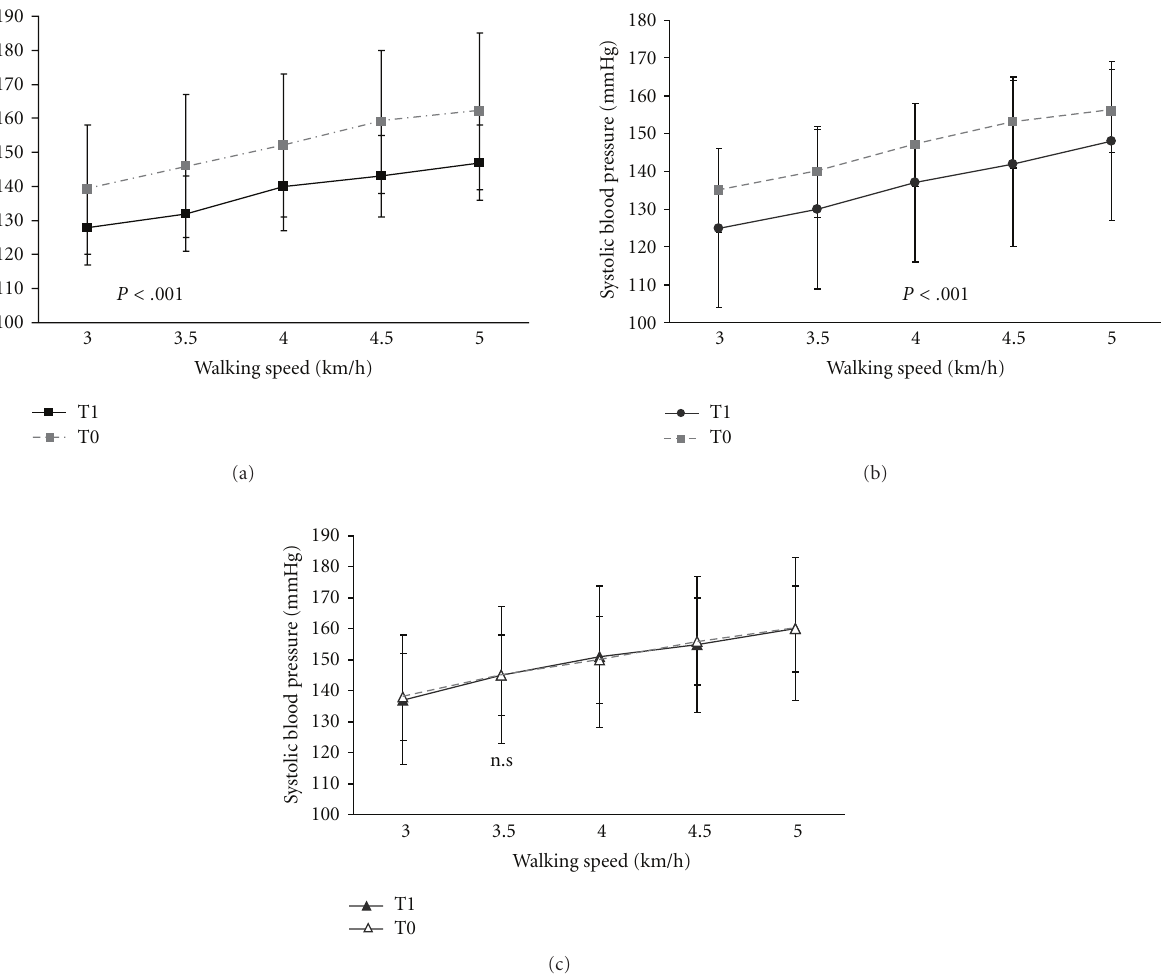
Figure 6: (a) The increase of the systolic blood pressure with increasing walking speed was significantly lower after completion of the training programme in the Nordic walking ((a)) and the walking group ((b)) but not in the flexibility and relaxation group; ((c)) T0 = first assessment, T1 = second assessment, error bars indicate the standard deviation. (b) Walking group. T0 = first assessment, T1 = second assessment, error bars indicate the standard deviation. (c) Flexibility and relaxation group, there was no di ff erence between the first and second assessment; T0 = first assessment, T1 = second assessment, error bars indicate the standard